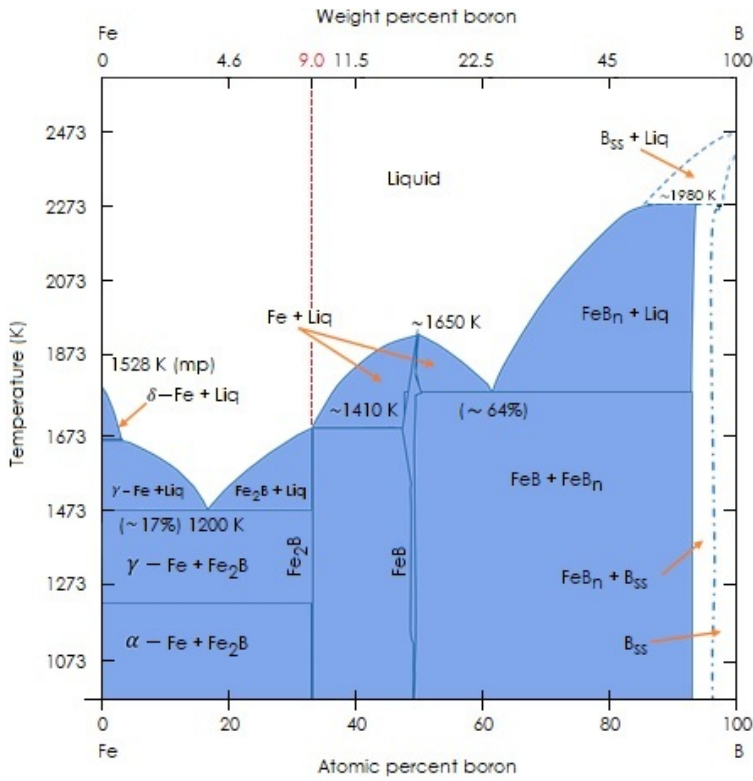
Figure 5. Phase diagrams of the Fe-B system.